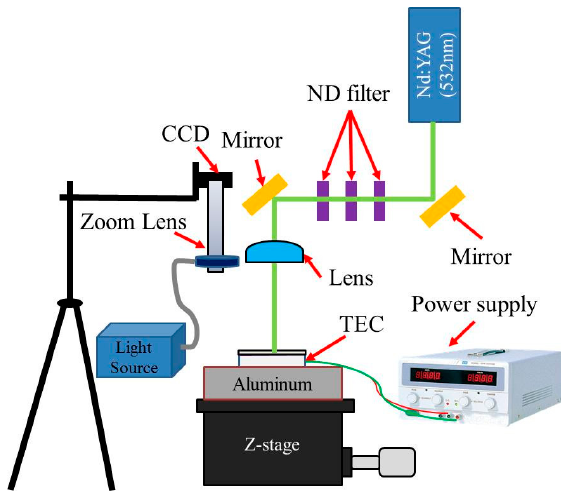
Figure 2. Schematic view of the experimental setup.